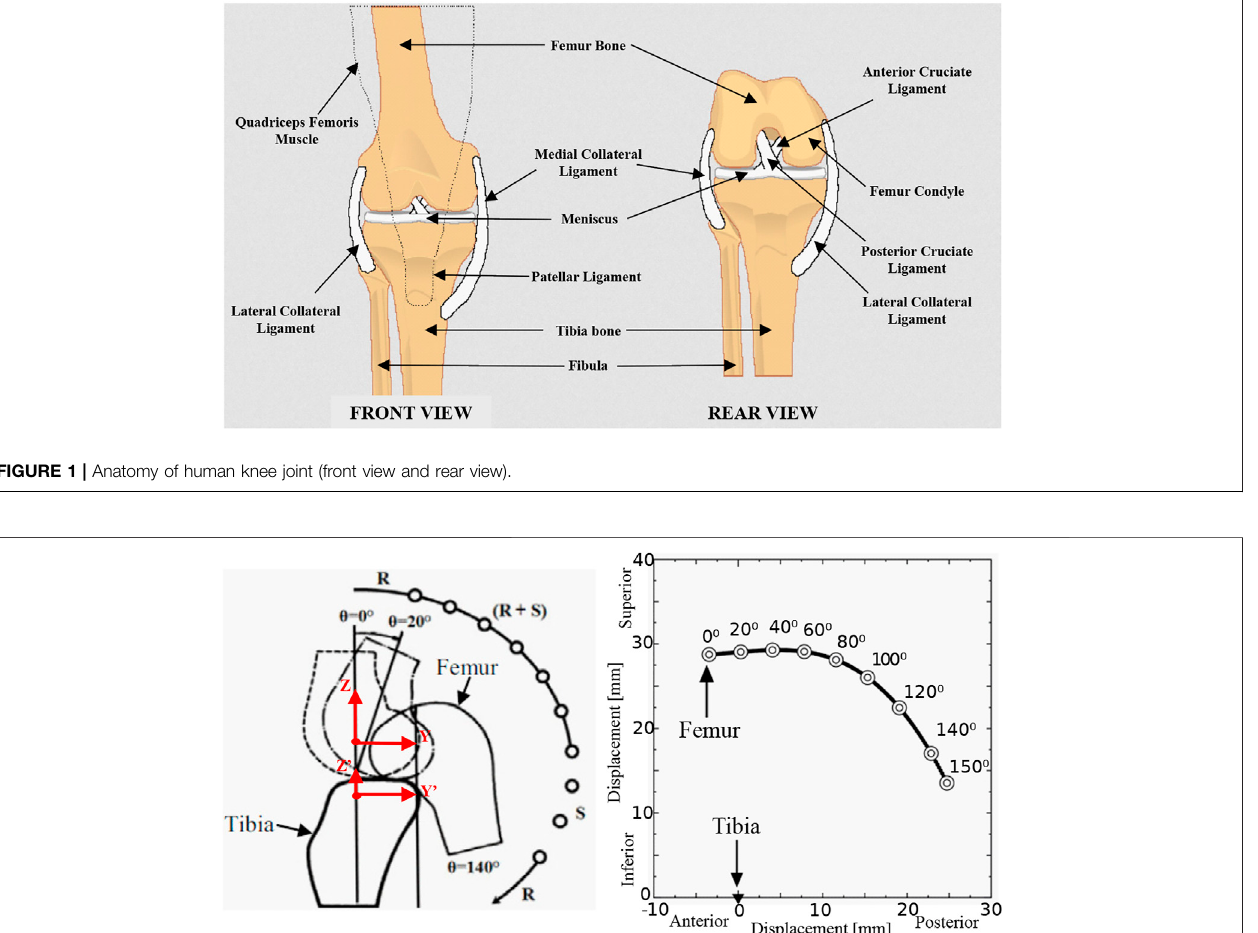
Frontiers in Robotics and AI |